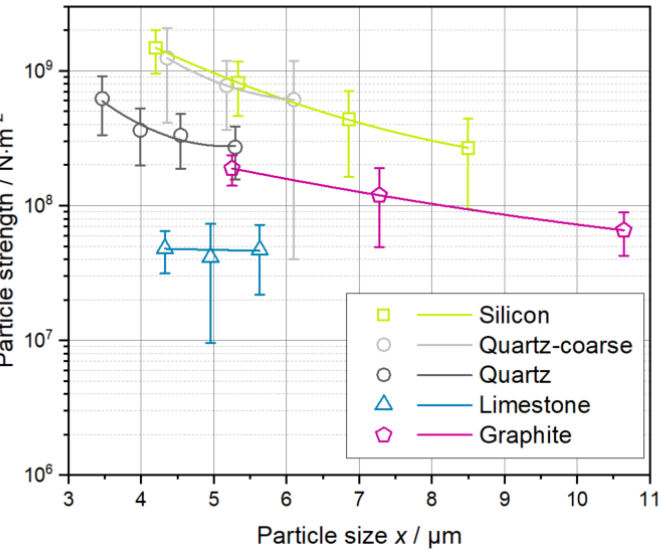
Figure 7. Particle strength as a function of particle size for five particle types investigated.